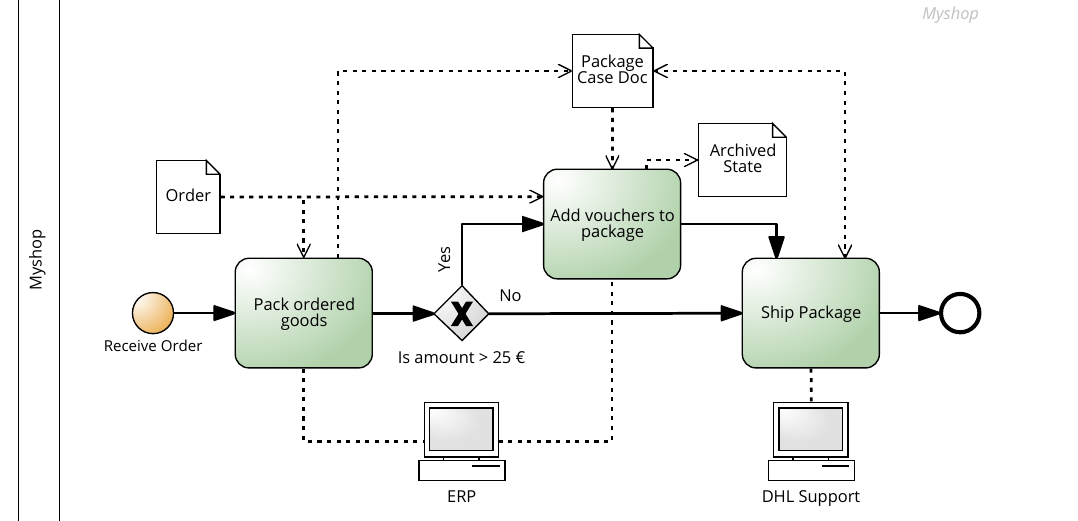
Figure 1. An example of an equivalent model to the spreadsheet-based process description presented in Table 1 (based on